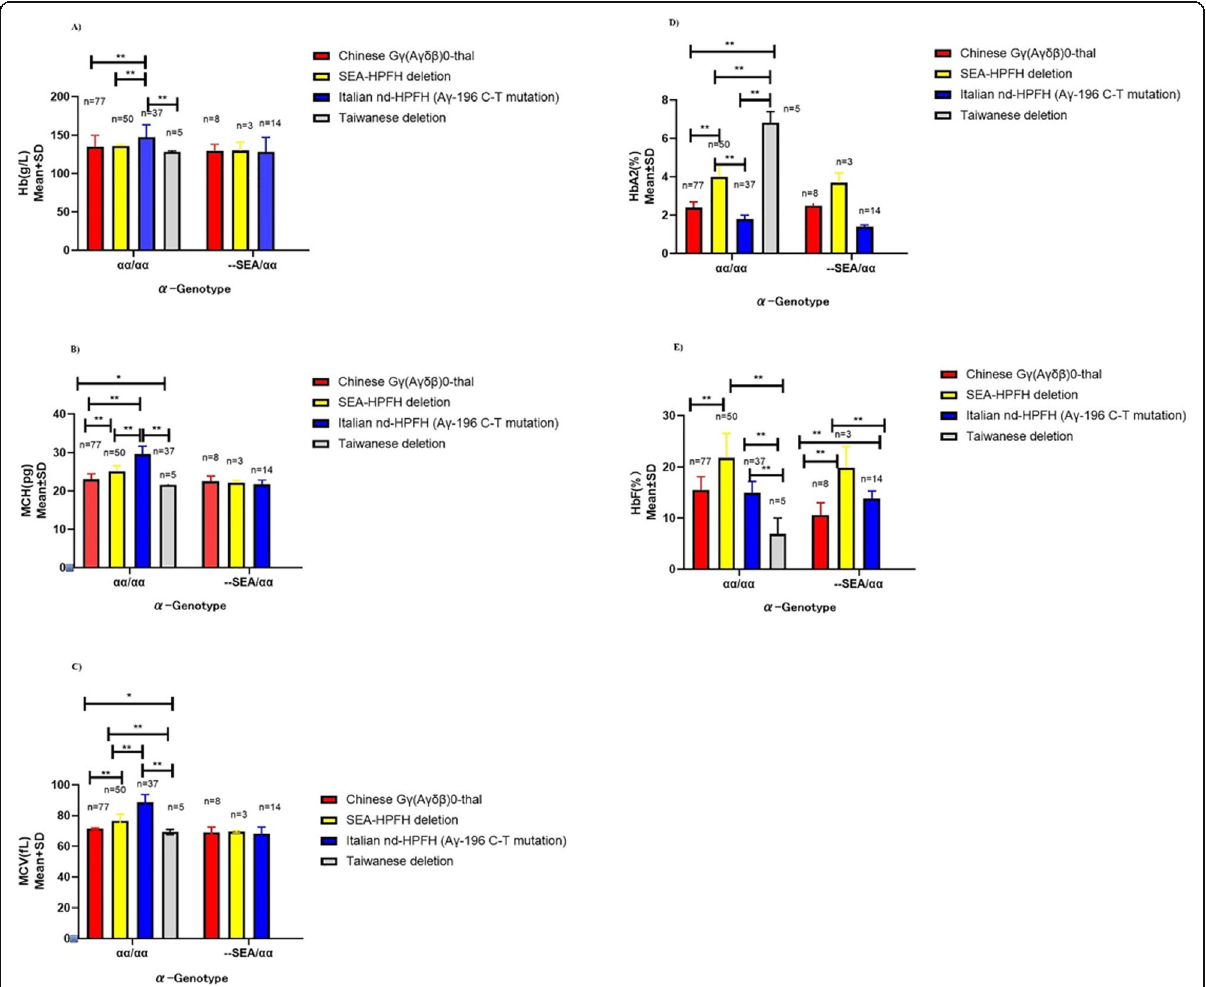
Fig. 4 Hematological parameter analysis of heterozygotes of Chinese G γ ( A γδβ ) 0 thalassemia, SEA-HPFH, Taiwanese deletion, and Italian nd-HPFH. Comparisons of hemoglobin (Hb) ( a ), mean corpuscular volume (MCV) ( b ), mean corpuscular hemoglobin ( c ), hemoglobin A2 (HbA2) ( d ), and fetal hemoglobin (HbF) ( e ) levels of those four types of δβ -thalassemia/HPFH with or without coinherited α 0 -thalassaemia (southeast Asian type deletion). Mean ± standard deviation (SD) isused to describe hematological parameters. A p -value of less than 0.05 showing significant differences: ** p < 0.01; * p <